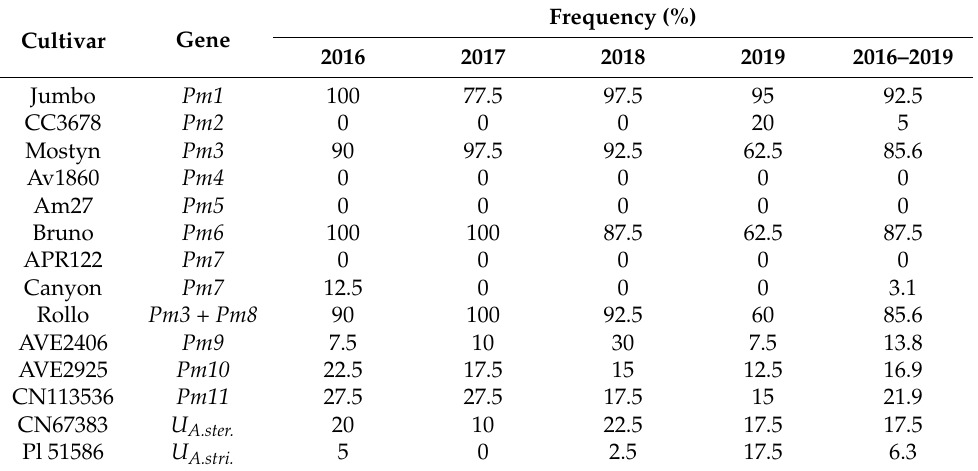
Table 3. Virulence frequencies of Blumeria graminis f. sp. avenae isolates sampled from oat in